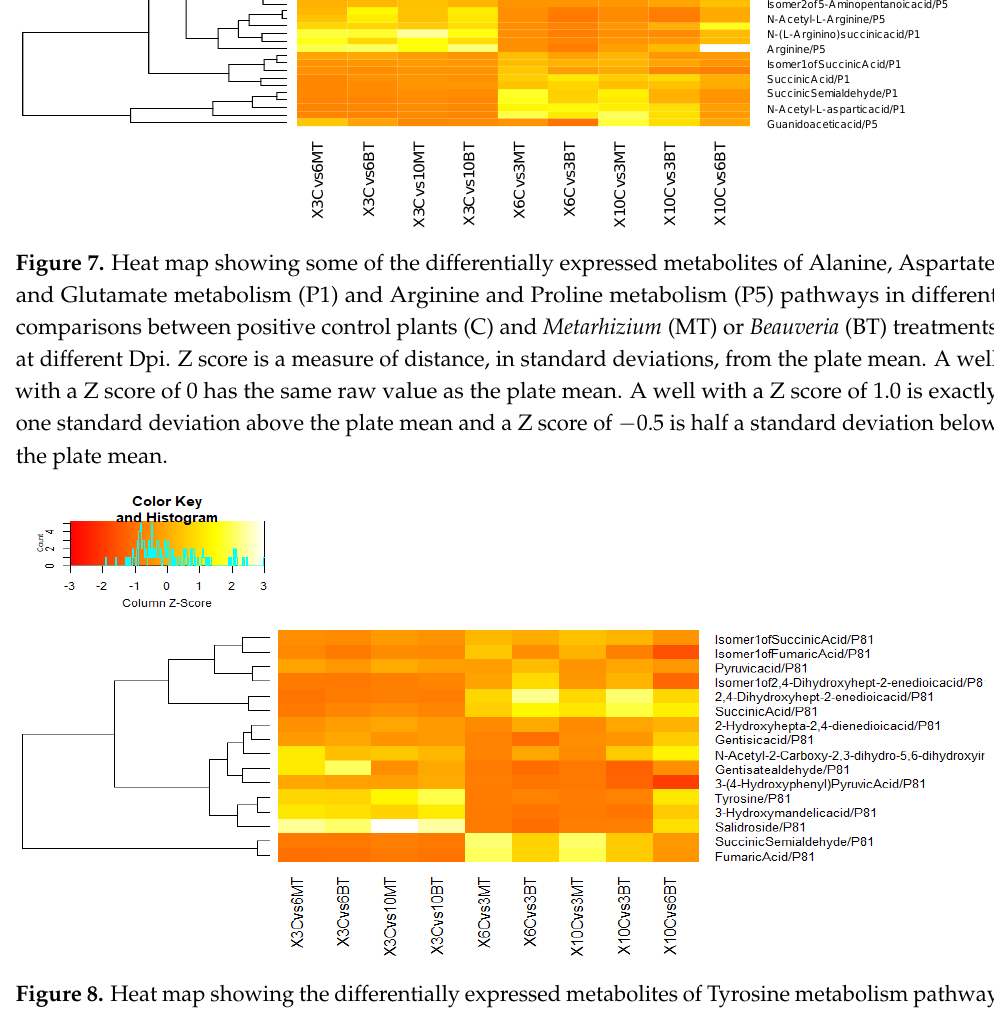
Figure 8. Heat map showing the differentially expressed metabolites of Tyrosine metabolism pathway (P81) in different comparisons between positive control plants (C) and Metarhizium (MT) or Beauveria (BT) treatments at different Dpi. Z score is a measure of distance, in standard deviations, from the plate mean. A well with a Z score of 0 has the same raw value as the plate mean. A well with a Z score of 1.0 is exactly one standard deviation above the plate mean and a Z score of −0.5 is half a standard deviation below the plate mean.